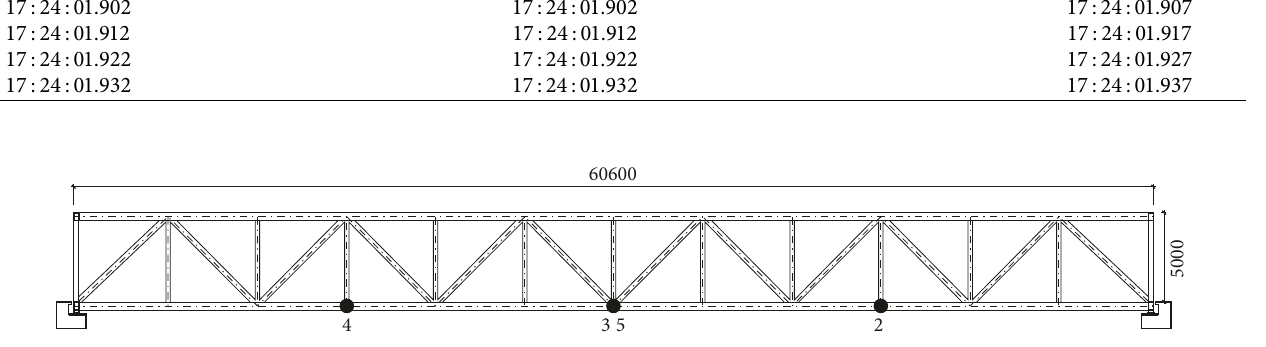
Figure 8: 60 m aerial corridor structure vibration test point layout (front view).